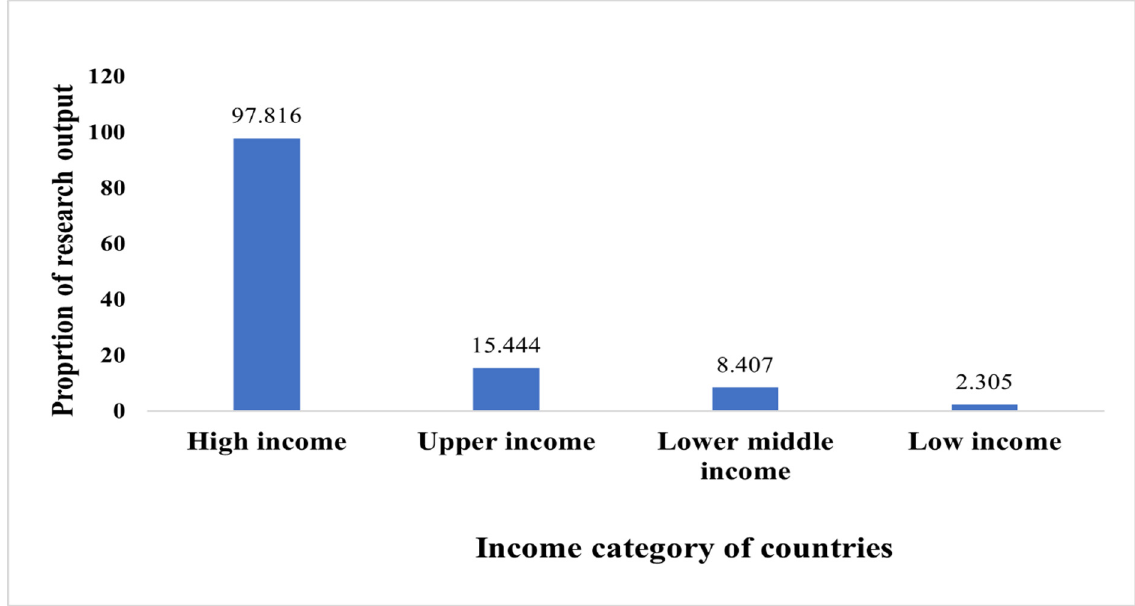
Figure 2. Regional contributors of patient education research (includes multi-authored studies).